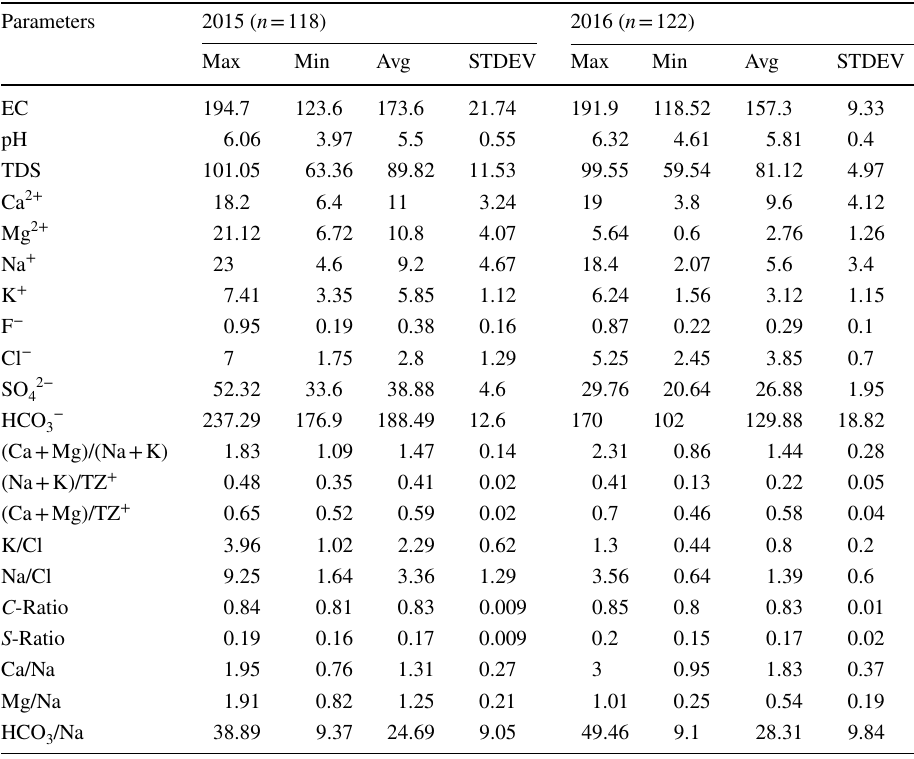
Table 5 Estimation of daily and entire ablation periods Individual Ion Flux (IIF), cation flux (F + ), anion flux (F − ), cation denudation rate (R + ) and anion denudation rate (R − ) of the Chaturangi glacier catchment in year 2015